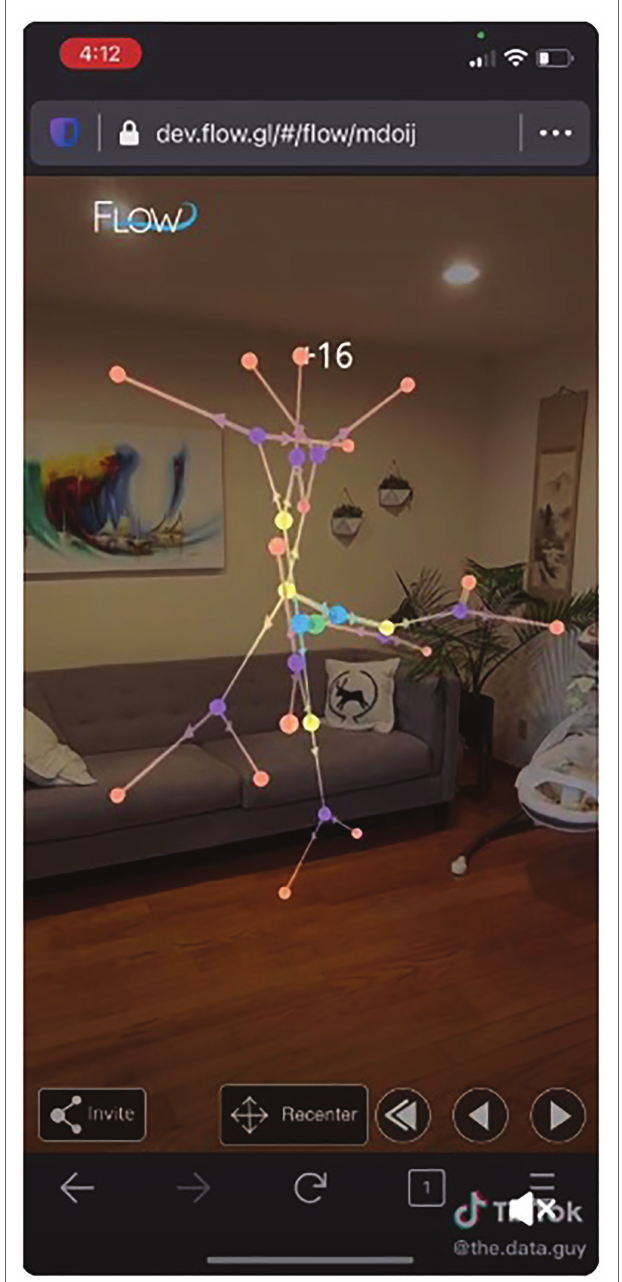
FIGURE 5 | A snapshot from the TikTok animation illustrating how super- spreader events were driving Covid-19 infections. The two blue nodes represent the first two